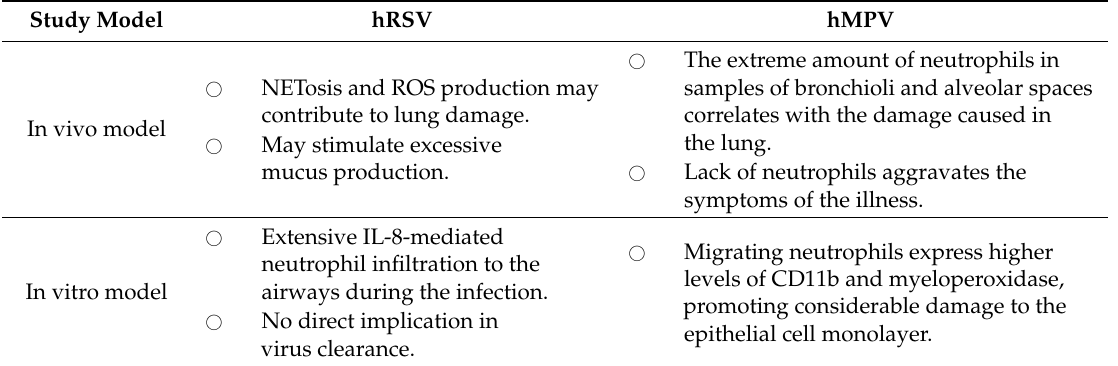
Table 3. Role of neutrophils in the pathology caused by hRSV and